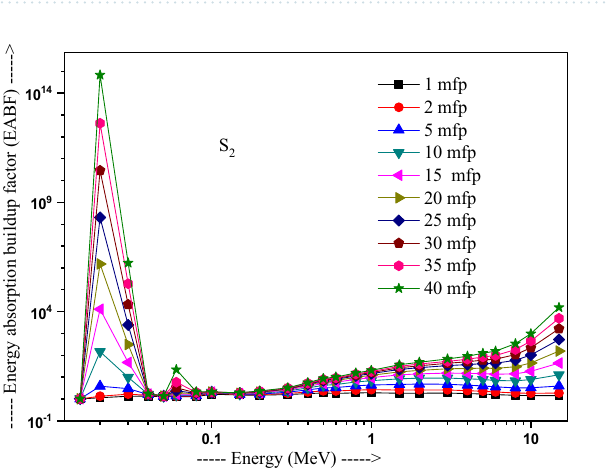
Figure 14. Variation of energy absorption buildup factor with energy for 20Bi 2 O 3 − xPbO − (80 − 2x) B 2 O 3 − xGeO 2 (x = 5) glass (S 1 ).